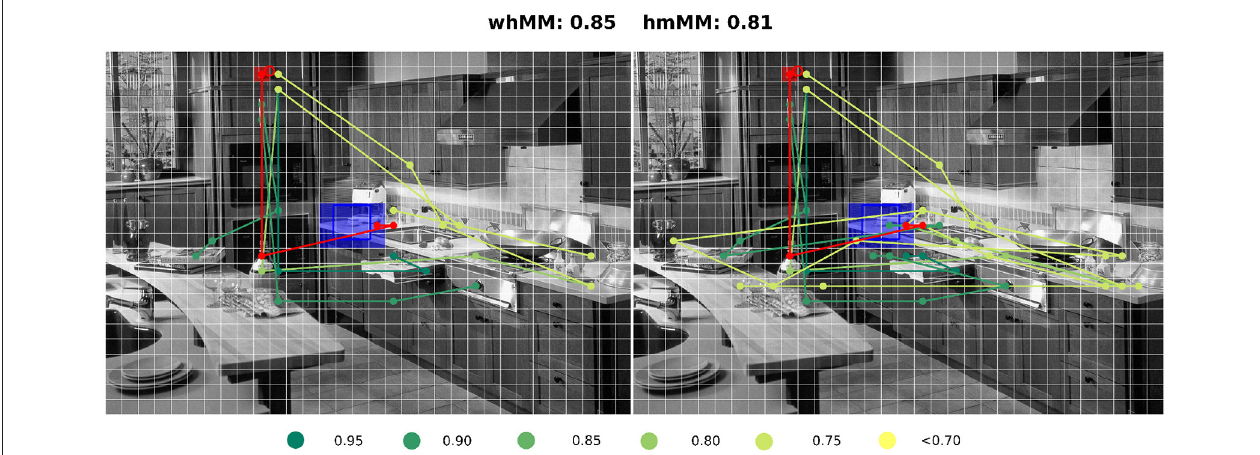
FIGURE 6 | Comparison of scanpath predictions. The figure is meshed by a fixed grid of δ = 32px. Each curve represents a scanpath, in red the cIBS+DGII model’s scanpath, and in green and yellow six scanpaths of participants colored according to their similarity to the model scanpath. The (left) panel shows the first four fixations of each scanpath, and the (right) panel shows the entire scanpaths. The search target is represented with the blue square and the approximated first fixation with the red square. Above the image, the whMM and hmMM for this trial are reported. Image taken from Wikipedia Commons